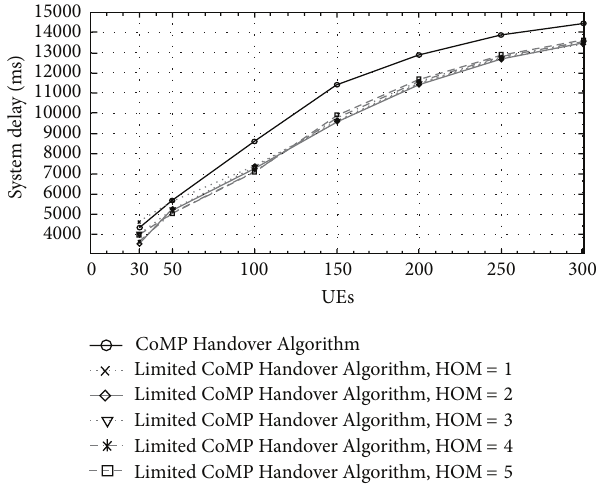
Figure 9: System Delay of CoMP Handover Algorithm and Limited CoMP Handover Algorithm in